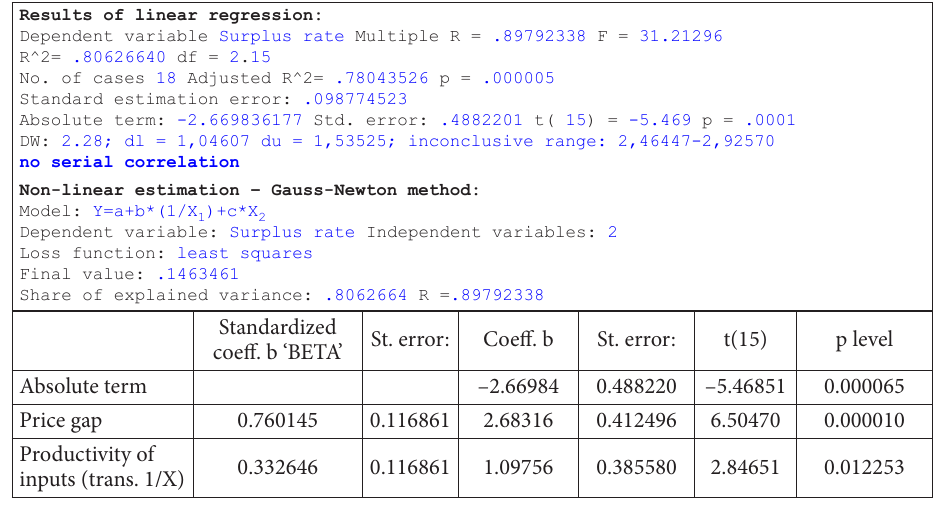
Table 3. Estimation of model 2 parameters